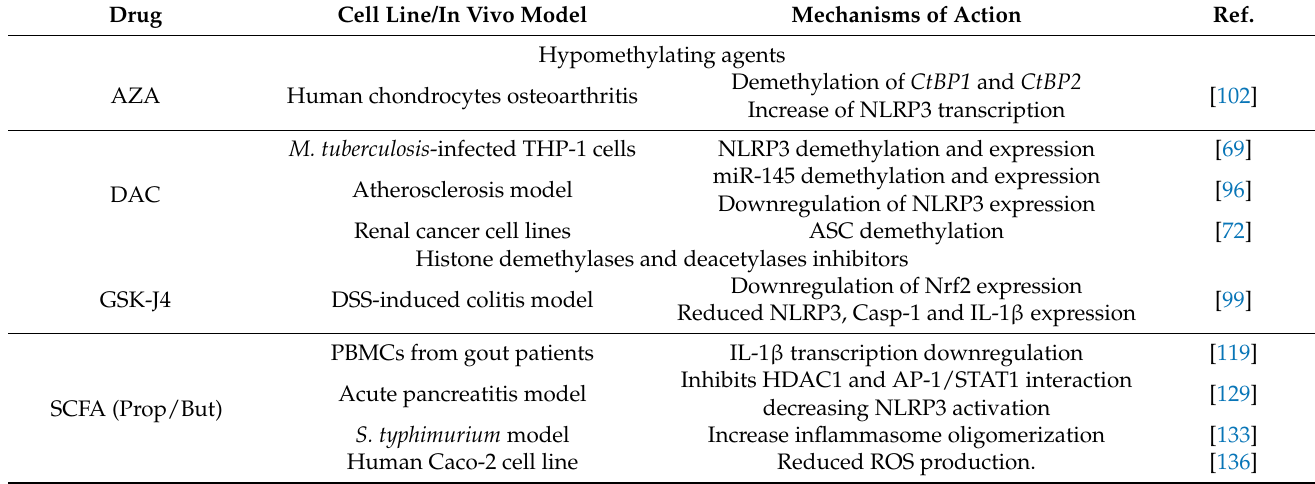
Table 1. Epigenetic treatments targeting the NLRP3 inflammasome